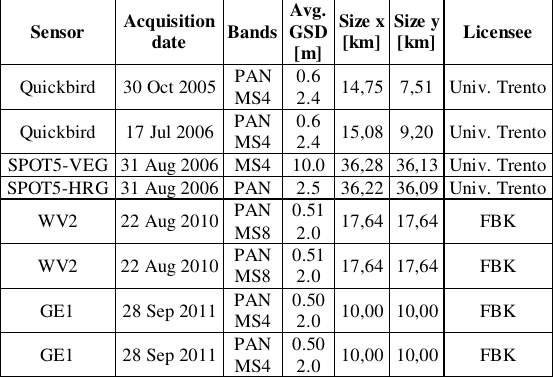
Trento GNSS permanent station in order to achieve sub- decimetre accuracy. - 12 ground points, located on building corners and roofs acquired in January 2012 by Total Station. - GIS vector data for the whole province of Trento, consisting (mainly) of a topographic map at nominal scale of 1:10000, and a set of 447 cadastral maps in vector format at nominal scale of 1:1000. Table 1. Characteristics of satellite imagery in the Trento testfield. PAN: panchromatic, MS4: multispectral (4 bands), MS8: multispectral (8 bands), GSD: Ground Sample